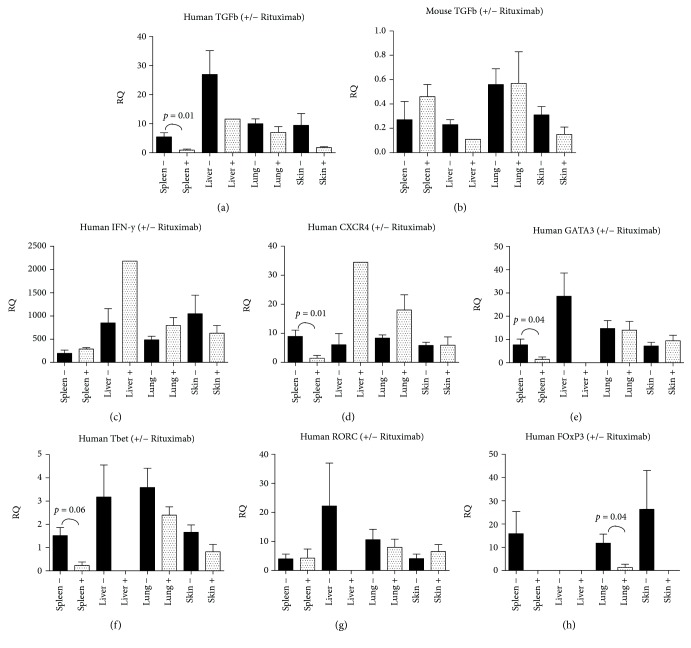
Expression of mRNA for fibrogenic proteins and specific cell marker mRNA in early B-cell depletion. RQ values are shown from the early B-cell depletion experiment; RAG2 −/−γc−/− mice injected with huPBMCs with Rituximab induced B-cell depletion (indicated as +) and RAG2 −/−γc−/− mice injected with huPBMCs without this depletion (indicated as -), for the most important observations, concerning human and murine TGF-β, human IFN-γ, and different human cell types, including FoxP3 (Tregs), GATA3 (Th2 cells), and Tbet (Th1 cells). All other results were either not significant (CD4, CD8, murine CD68, murine CTGF, murine BMP4), had cycle threshold (Ct) values > 35 (CD20 and human CD68) or were not detectable at all (human factors FGF2, PDGF, EGF, BMP4 and CTGF).